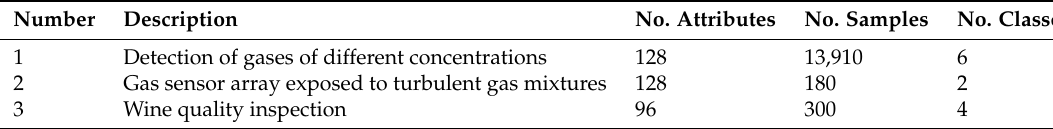
Table 4. Summary of all data